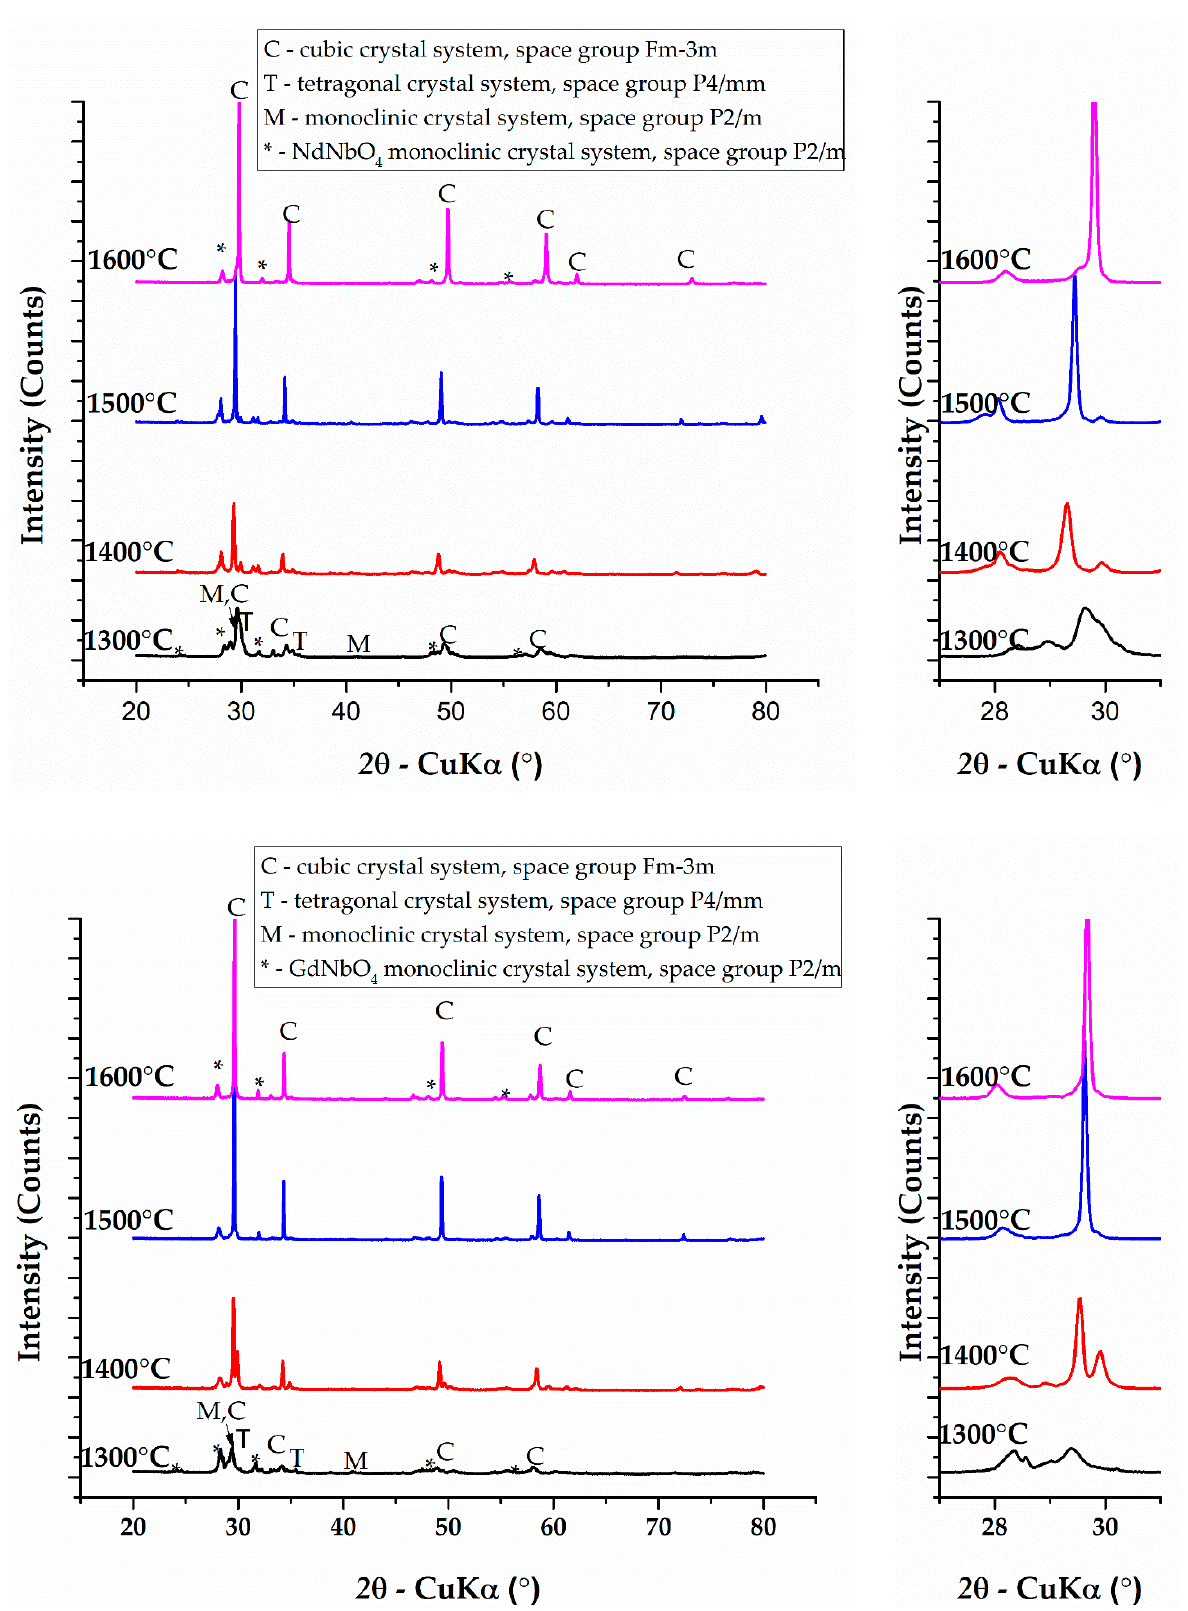
Figure 1. XRD patterns corresponding to samples heat-treated at 1300, 1400, 1500 and 1600 °C belonging to equimolar ZrO 2 -HfO 2 -CeO 2 -Nb 2 O 5 -RE 2 O 3 systems (RE = Y, Yb, Nd,